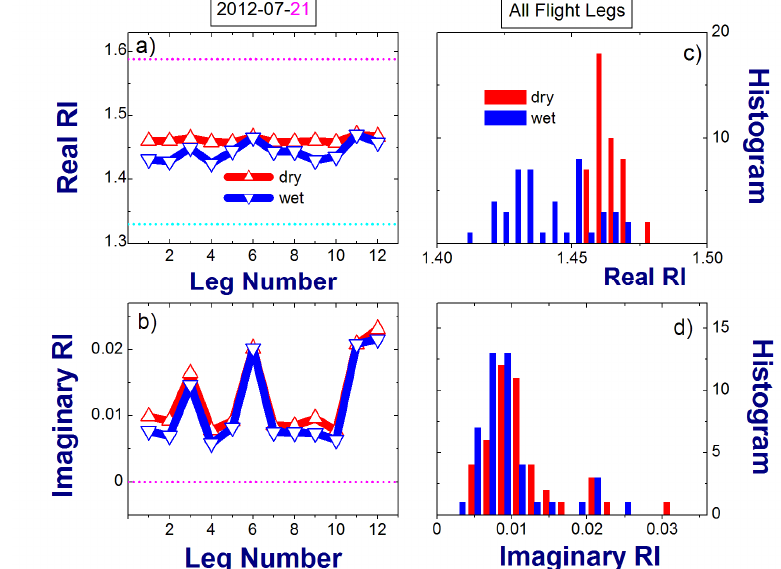
Figure 6. Example of RH-dependent dry and ambient values of the real and imaginary parts of the complex RI calculated for each FL during a given day (21 July 2012) ( a , b ); the corresponding histograms obtained for all TCAP FLs ( c , d ). The real (n OPC = 1.588) and imaginary (k OPC = 0) parts of the complex RI used for OPC calibration are shown in (a) (magenta) and (b) (magenta), respectively. The real RI of water (n water = 1.33) is also shown (a, cyan). The imaginary RI of water (k water = 0) is equal to the imaginary RI used for OPC calibration (k OPC =